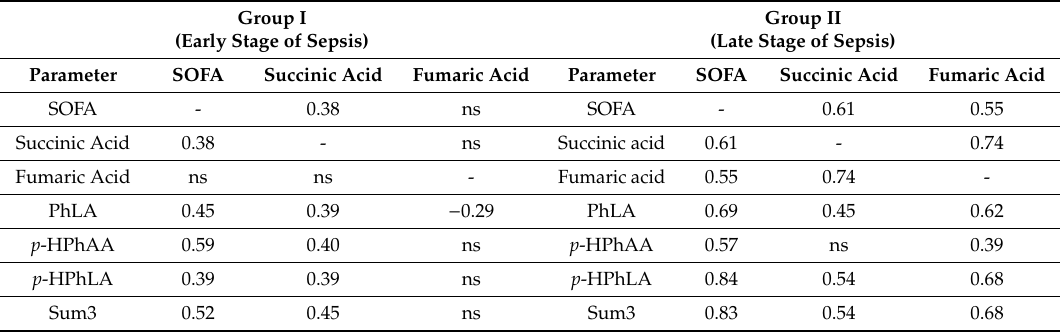
Table 2. Correlations ( r ) of the SOFA score with serum levels of mitochondrial metabolites and phenylcarboxylic acids in septic patients ( p < 0.05